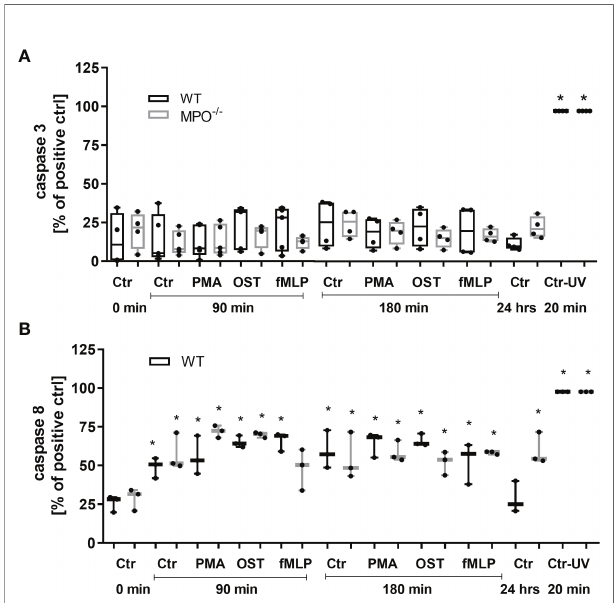
FIGURE 3 | Activity of caspase 3 (A) and 8 (B) in PMNs isolated from in fl amed lungs of WT and MPO -/- mice after the induction of oxidative burst by PMA, OST, and fMLP for 90 min and 180 min. PMNs (1x 10 7 cells/ml) isolated from BALF of WT and MPO -/- mice were stimulated with PMA (80 nM), OST (1:10 MOI) and fMLP (1.14 m M) for 90 and 180 min. PMNs incubated for 24 h without stimulation and PMNs irradiated by UV for 20 min were also used as a positive control. Next, cells were lysed and caspase 3 or caspase 8 activity was determined by enzymatic assay. Data are presented as median, 25, and 75 percentiles (the box) and 10 and 90 percentiles (the whiskers), and individual values are drawn as individual dots, n = 3 - 4. *Shows statistically signi fi cant difference (p < 0.05) compared with untreated control